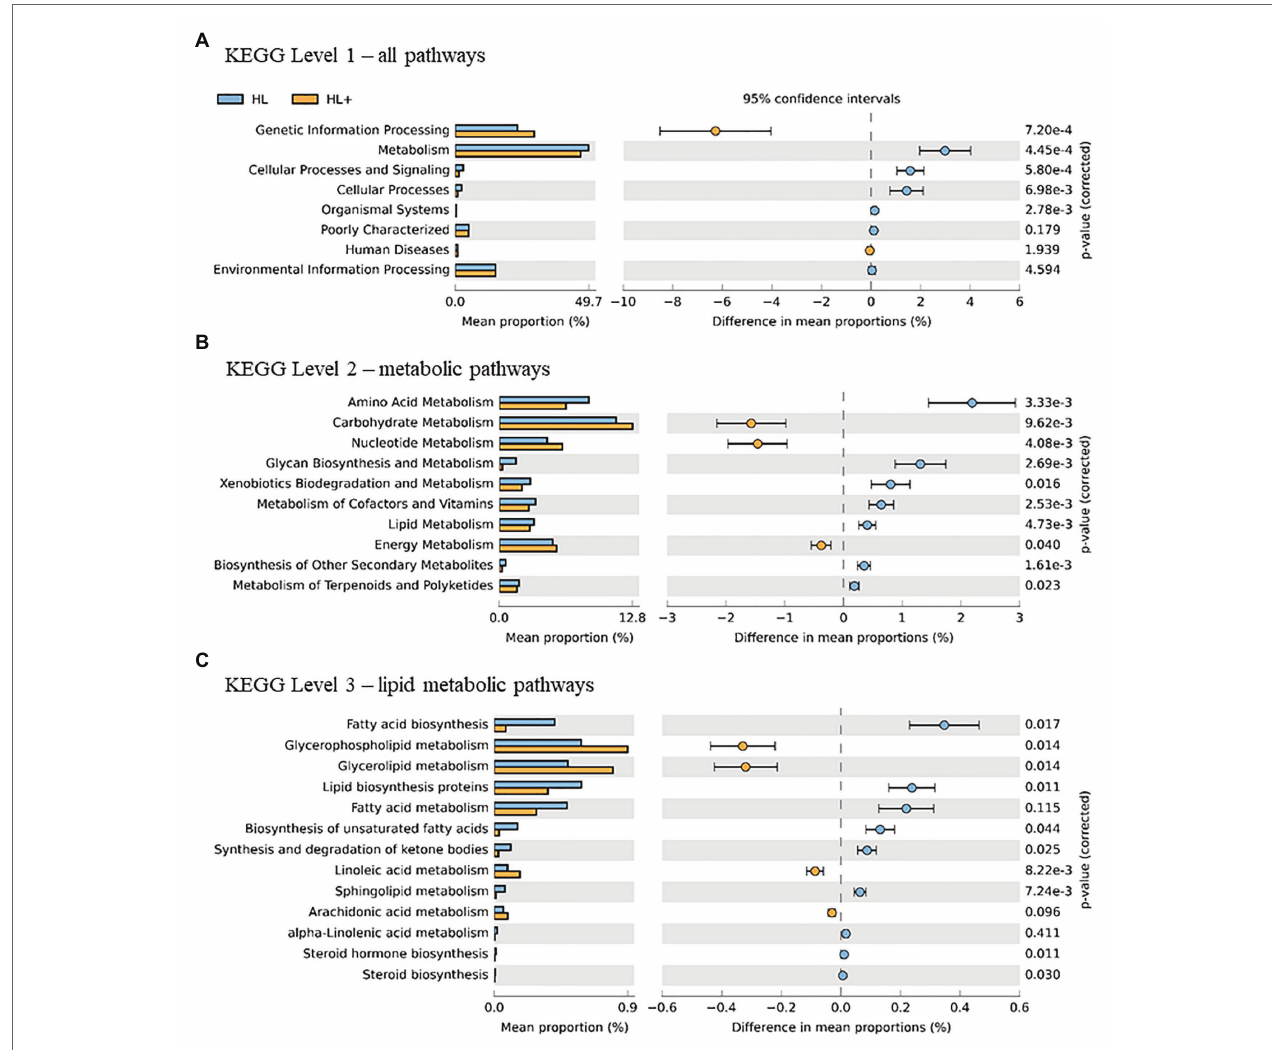
FIGURE 6 | Statistical Analysis of Taxonomic and Functional Profiles (STAMP) plots of predictive metagenomic analysis using phylogenetic investigation of communities by reconstruction of unobserved states (PICRUSt) to infer function of the distal intestine microbiome ( N = 72) of Atlantic salmon on day 116 fed HL and high lipid with additional n-3 LC-PUFA (HL+). Kyoto Encyclopedia of Genes and Genomes (KEGG) Level 1 includes all pathways (A) , two includes metabolic pathways (B) , and three includes lipid metabolic pathways (C) . p- values were generated by Welch’s t -test with Bonferroni correction and <0.05 was considered